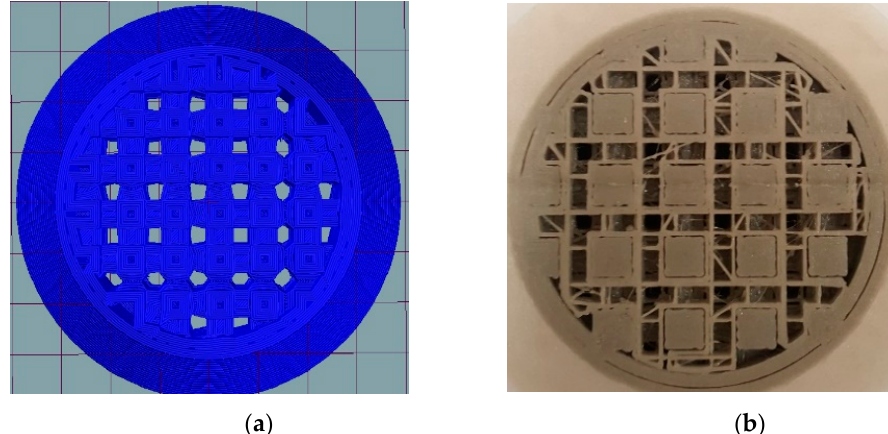
Figure 5. X-sectional top views of test specimen with frequency “19”and vertical shift “0” ( a ) after rendering plus slicing ( b ) after printing.